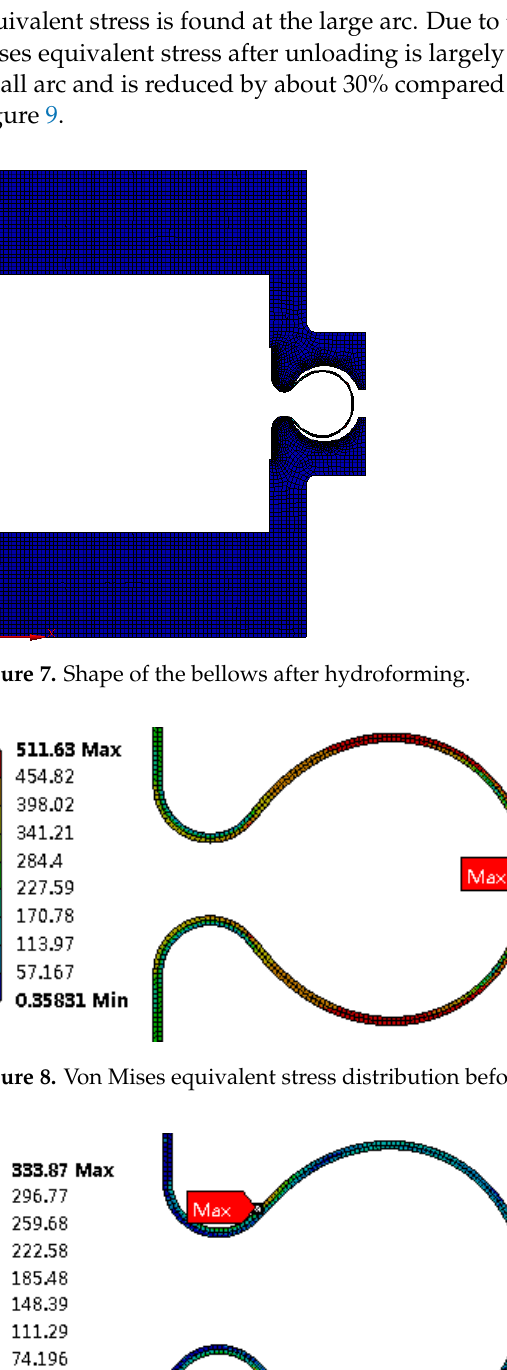
Figure 6. Constraint setting for the simulation.